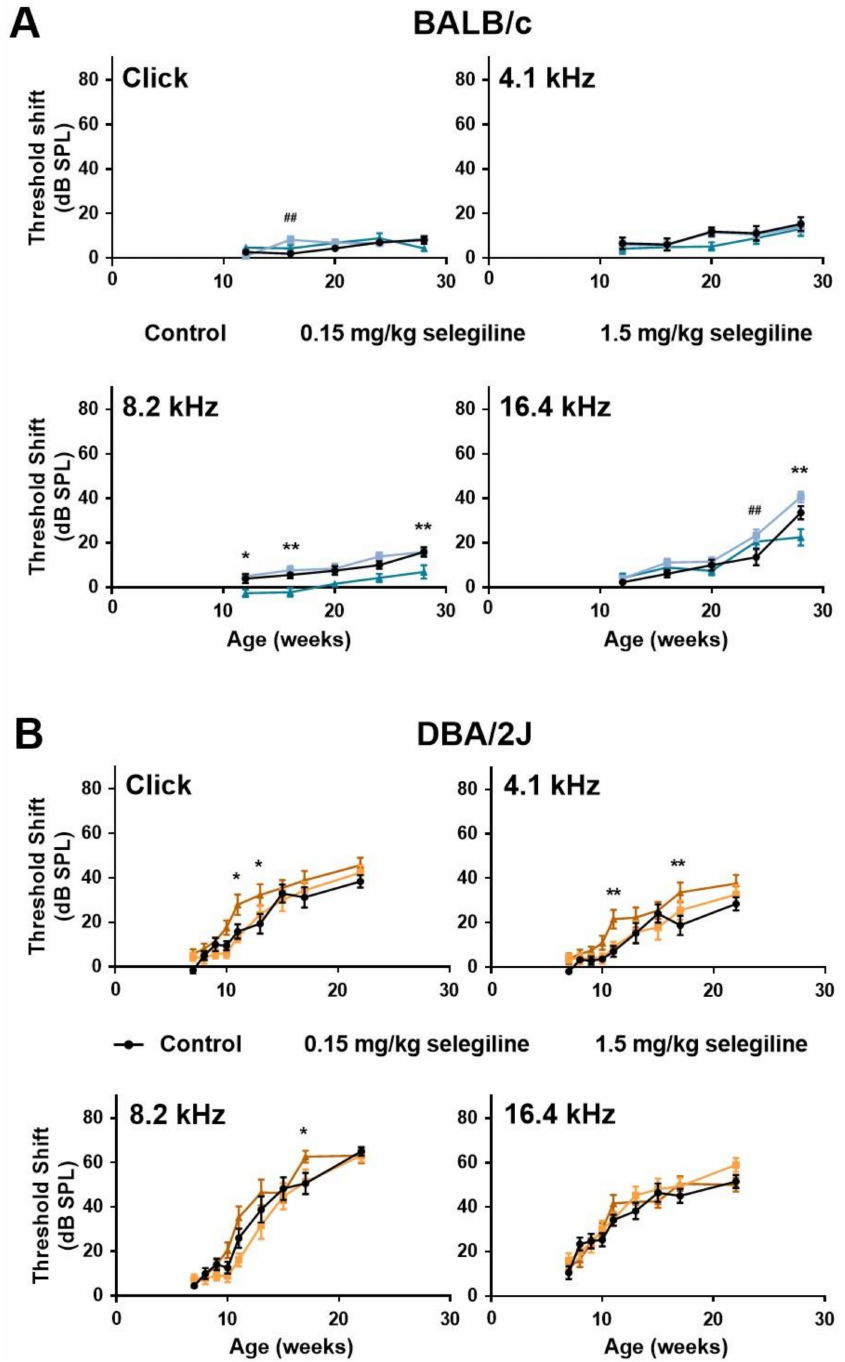
Figure 2. Effect of chronic oral selegiline administration on age-related hearing loss in BALB/c and DBA/2J mice. The drug was added to drinking water. The hearing function was followed by repeated ABR measurements in both the click and tone burst (Figure 1). Treatment of BALB/c ( A ) and DBA/2J ( B ) mice with 0.15 and 1.5 mg/kg selegiline. Data represents mean ± SEM. Two-way ANOVA followed by Bonferroni post-hoc test. 0.15 mg/kg (## p < 0.01) and 1.5 mg/kg (* p < 0.05, ** p < 0.01) selegiline vs. control (see Section